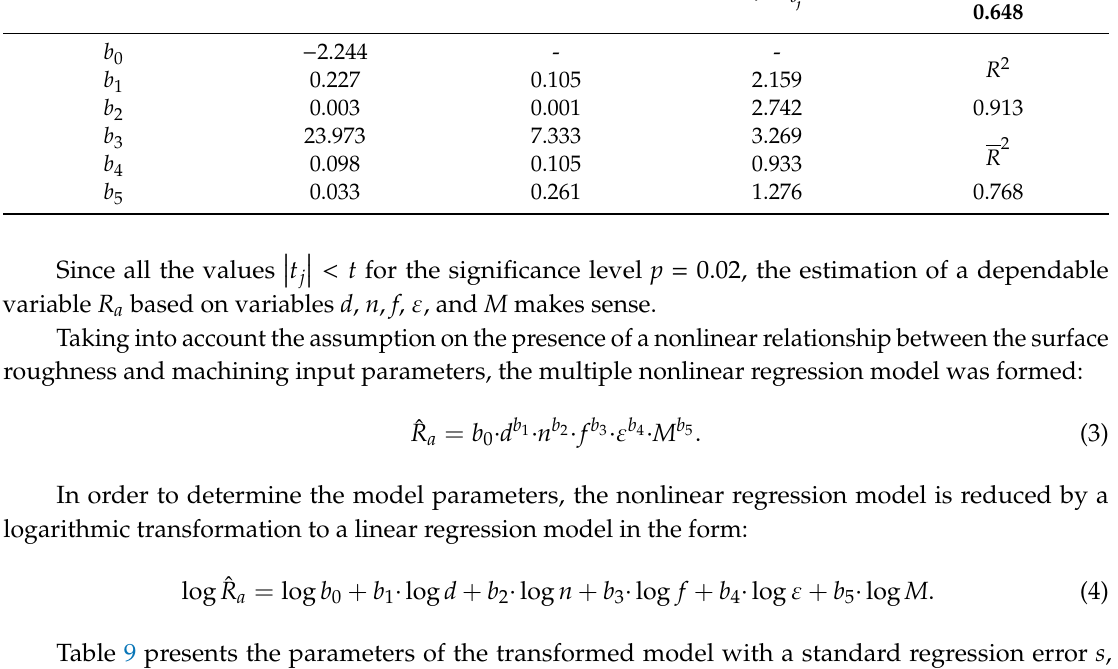
Table 8. The parameters of a multiple linear regression model with a torque for twist drills (TD) drilling with cruciform blade (CB) in test tubes hardness 28 HRC. Model